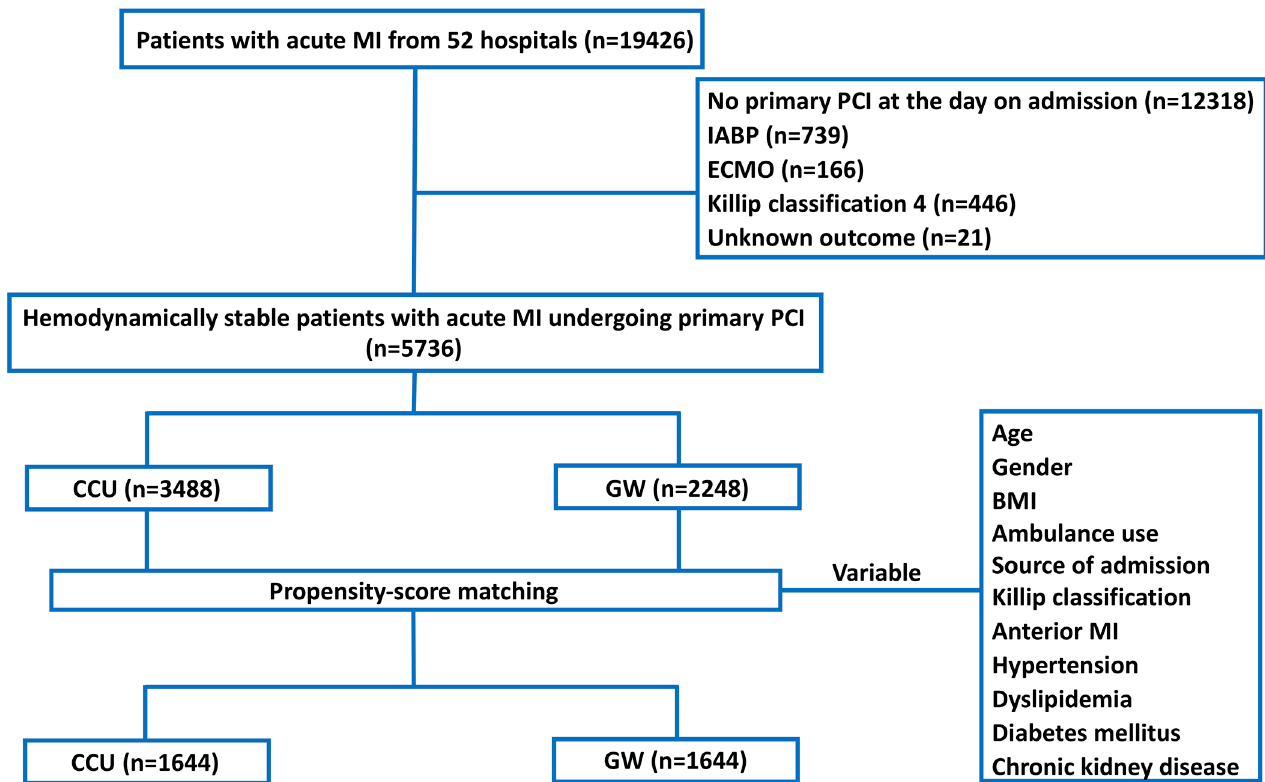
Fig 1. Flowchart of the study population. Emergency IABP and ECMO are defined as the procedures performed on the day of admission. BMI, body mass index; CCU, coronary care unit; ECMO, extracorporeal membrane oxygenation; GW, general ward; IABP, intra-aortic balloon pump; MI, myocardial infarction; PCI, percutaneous coronary